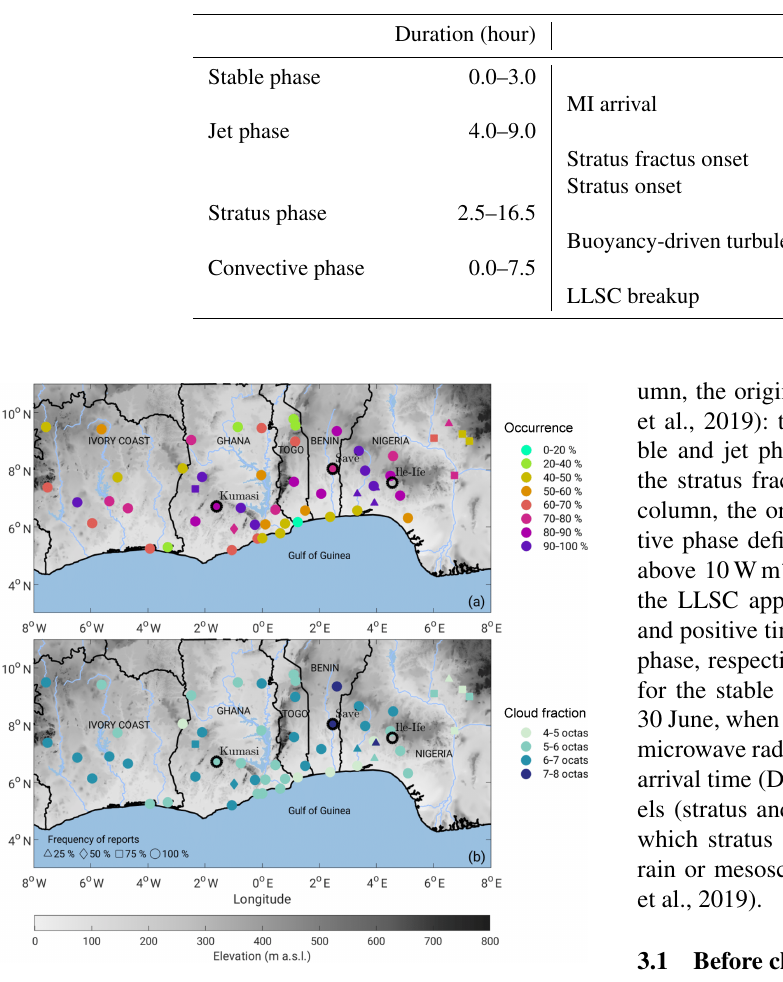
Figure 1. Topography (grey shading) of southern West Africa with superimposed (colour scale) (a) occurrence and (b) average cloud fraction of low-level clouds reported by the synoptic 55-station net- work at 06:00UTC during the DACCIWA field campaign (14 June– 31 July 2016). Only low clouds with more than 4 octas coverage are considered in the statistics. Frequency of reports (shape of the markers) indicates the percentage of days with available data during the whole period. The three supersites, Kumasi in Ghana, Savè in Benin, and Ile-Ife in Nigeria, are indicated with black